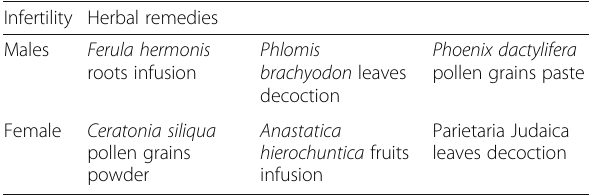
Table 4 The most cited herbal remedies used in the treatments of infertility in females and